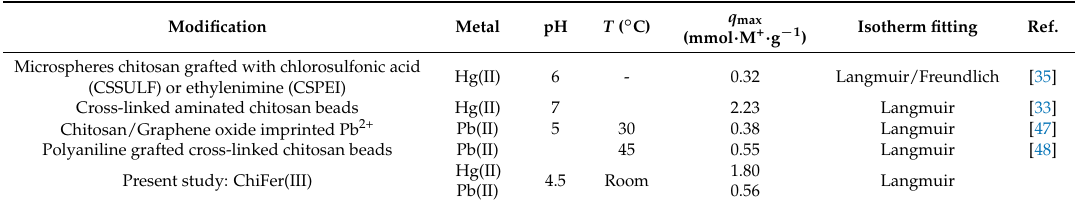
Table 2. Adsorption capacity of Hg(II) and Pb(II) with different chitosan-based